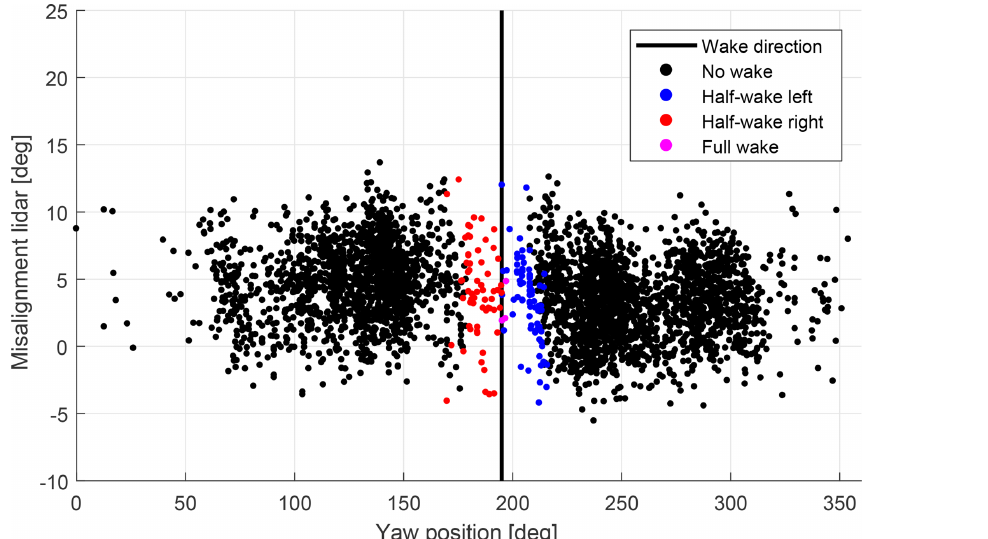
Figure 12. Lidar-estimated 10min mean yaw misalignment b φ as function of turbine yaw position. The vertical black line indicates the position of the upstream Nordtank turbine. Detected wake situations have been corrected according to the relationship found in Fig.